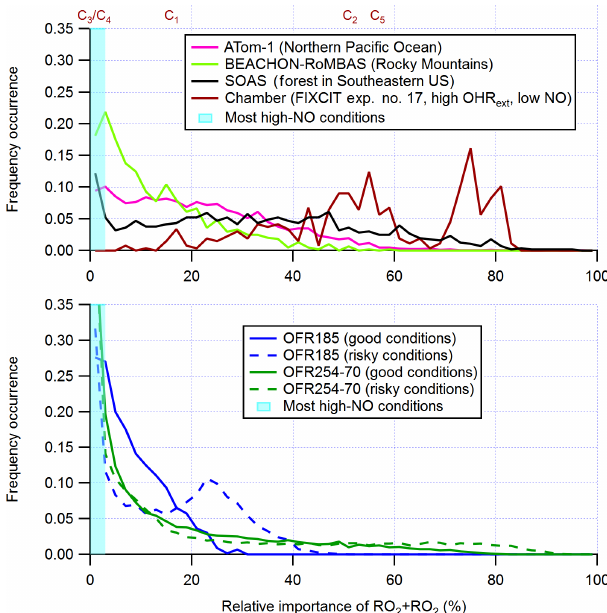
Figure 3. Frequency distributions of the relative importance of RO 2 + RO 2 in the fate of RO 2 (with fast self- and cross-reaction rate constant and without RO 2 + OH and RO 2 isomerization consid- ered) for OFR185 (including OFR185-iN 2 O), OFR254-70 (includ- ing OFR254-70-iN 2 O), and a chamber experiment and in the atmo- sphere (a couple of different environments). The OFR distributions for good and risky conditions (in terms of 254nm organic photoly- sis; see Table S1 for the definitions of these conditions) are shown separately. Also shown is the relative importance of RO 2 + RO 2 for several typical chamber cases (see Table 2 for details on these cases). The range of the RO 2 + RO 2 relative importance for most high-NO conditions is highlighted in